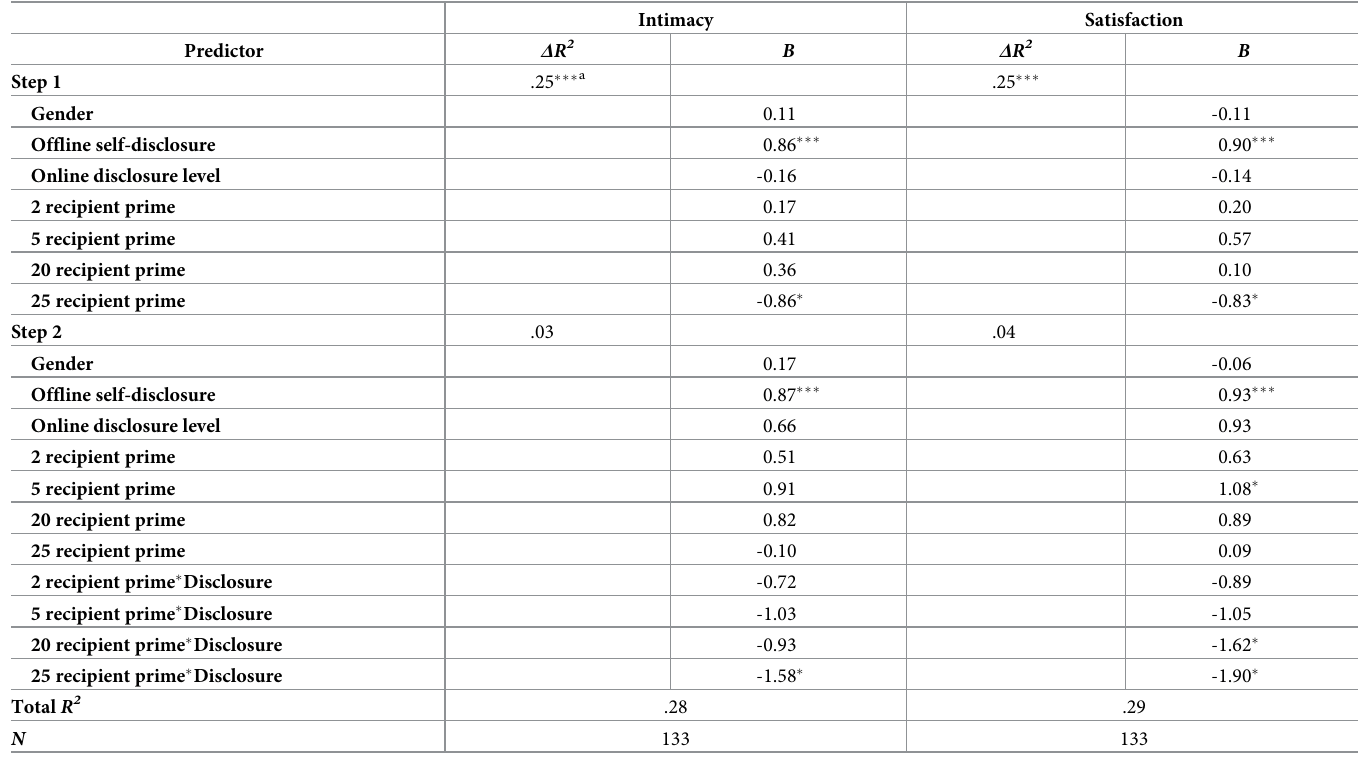
Table 5. Study 4 hierarchical regression analyses predicting relationship intimacy and